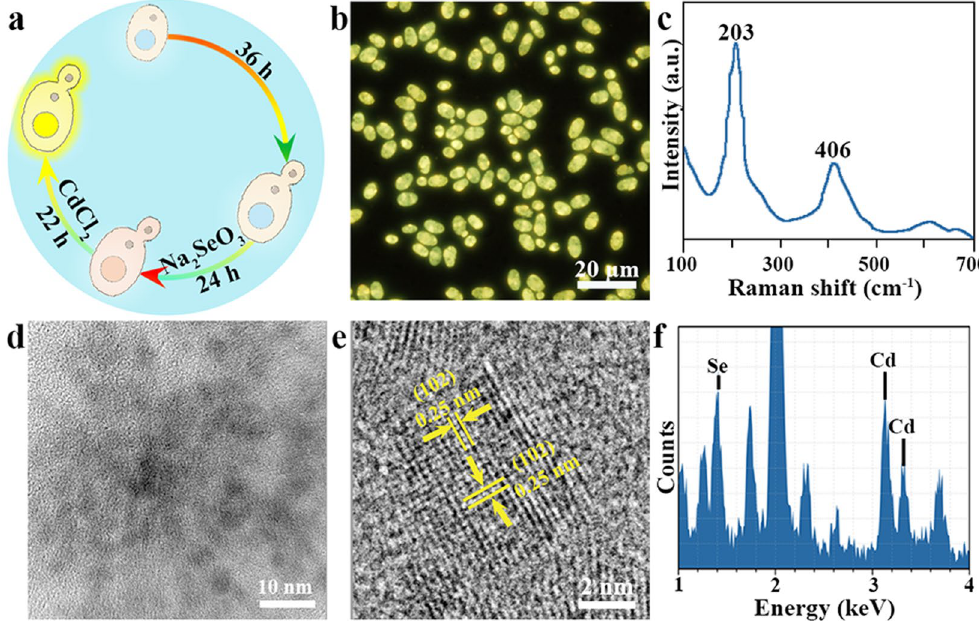
Figure 1. Characteristics of the CdSe QDs synthesized by C . utilis WSH02-08 with 1 mM Na 2 SeO 3 and 6 mM CdCl 2 . ( a ) Schematic illustration of bio-QDs fabrication process by Candida utilis WSH02-08. ( b ) Fluorescence microscopy image of cells exposed to Cd and Se salts. ( c ) In situ micro-Raman spectrum of the cells. ( d ) High- resolution transmission electron microscopy (HRTEM) image of the purified QDs. ( e ) The lattice planes spacing of the purified QDs is 0.25 nm. ( f ) X-ray energy-dispersive spectroscopy (EDS) analysis of the purified